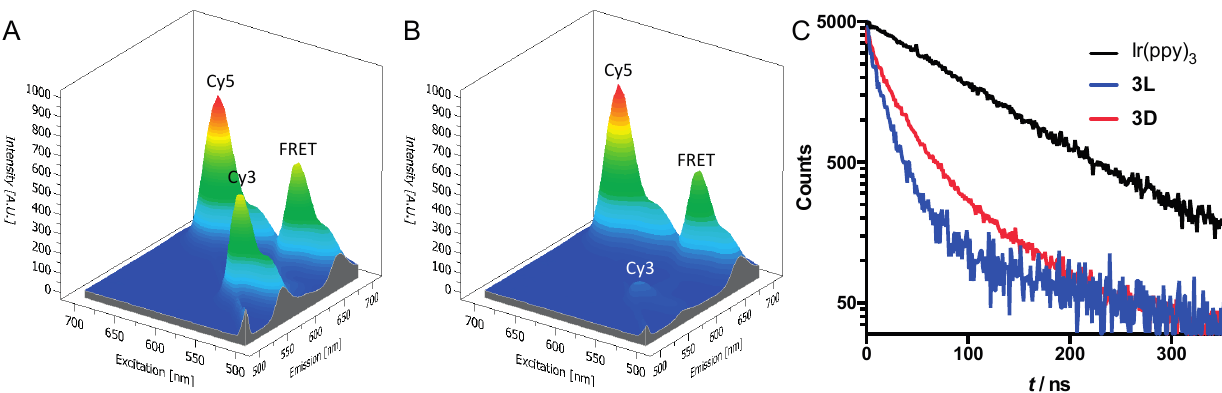
Figure 2. ( A , B ) Excitation-emission plots of peptides 2L ( A ) and 2D ( B ). The peaks labeled as “FRET” are the peaks that show acceptor emission (670 nm) with donor excitation (550 nm); ( C ) Luminescence decay traces at 600 nm of 3L , 3D , and reference